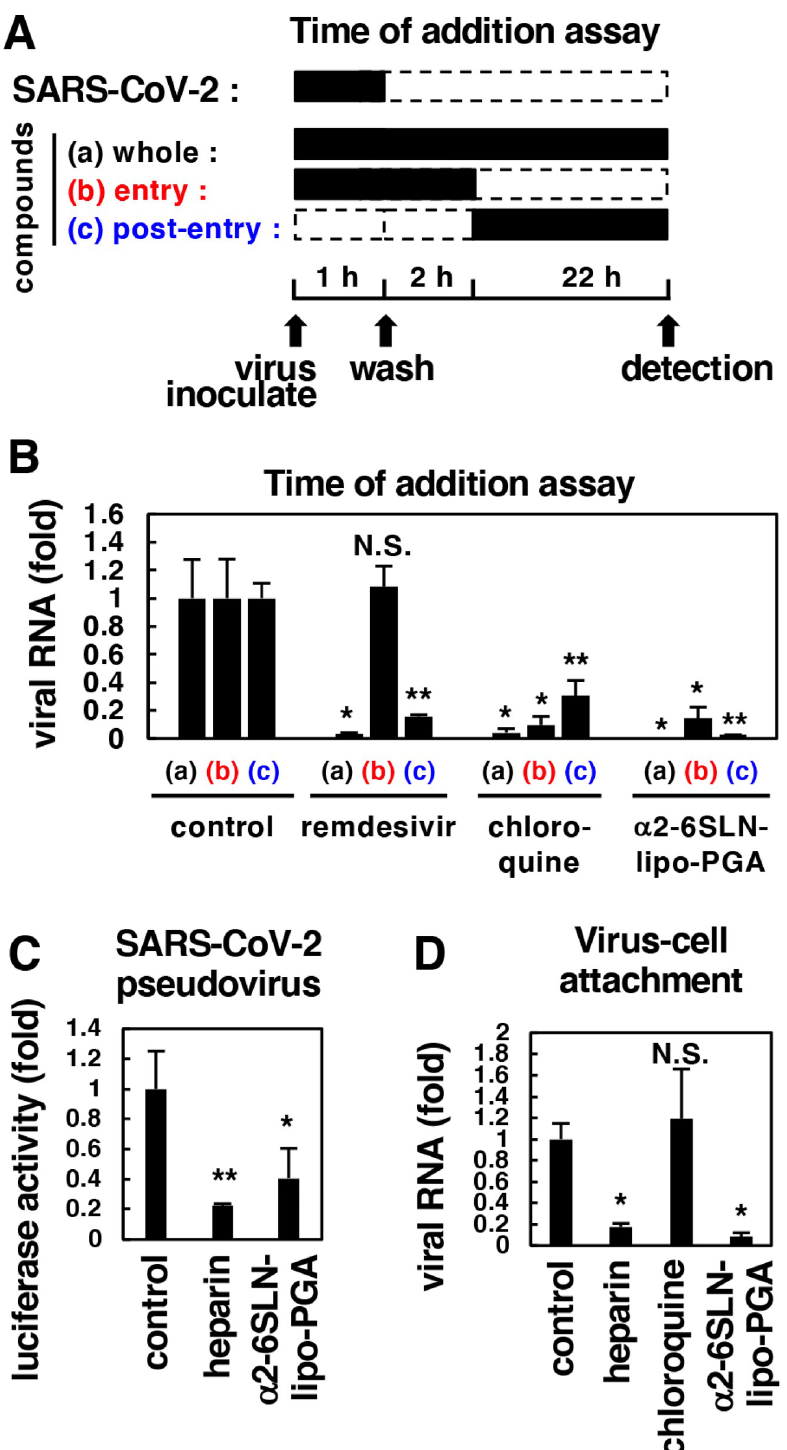
Fig 3. α 2-6SLN-lipo-PGA inhibited SARS-CoV-2 attachment. (A) Schematic representation of the schedule for treating VeroE6/TMPRSS2 cells with compounds and SARS-CoV-2 in time of addition analysis. Black and white boxes indicate the periods with and without treatment, respectively. (B) The antiviral activities of indicated compounds under treatment protocol as shown in (A) are estimated by quantifying the levels of secreted viral RNA at 24 h post- inoculation. Remdesivir, 8 μ M; chloroquine, 8 μ M; α 2-6SLN-lipo-PGA, 20 μ M. (C) SARS-CoV-2 attachment/entry